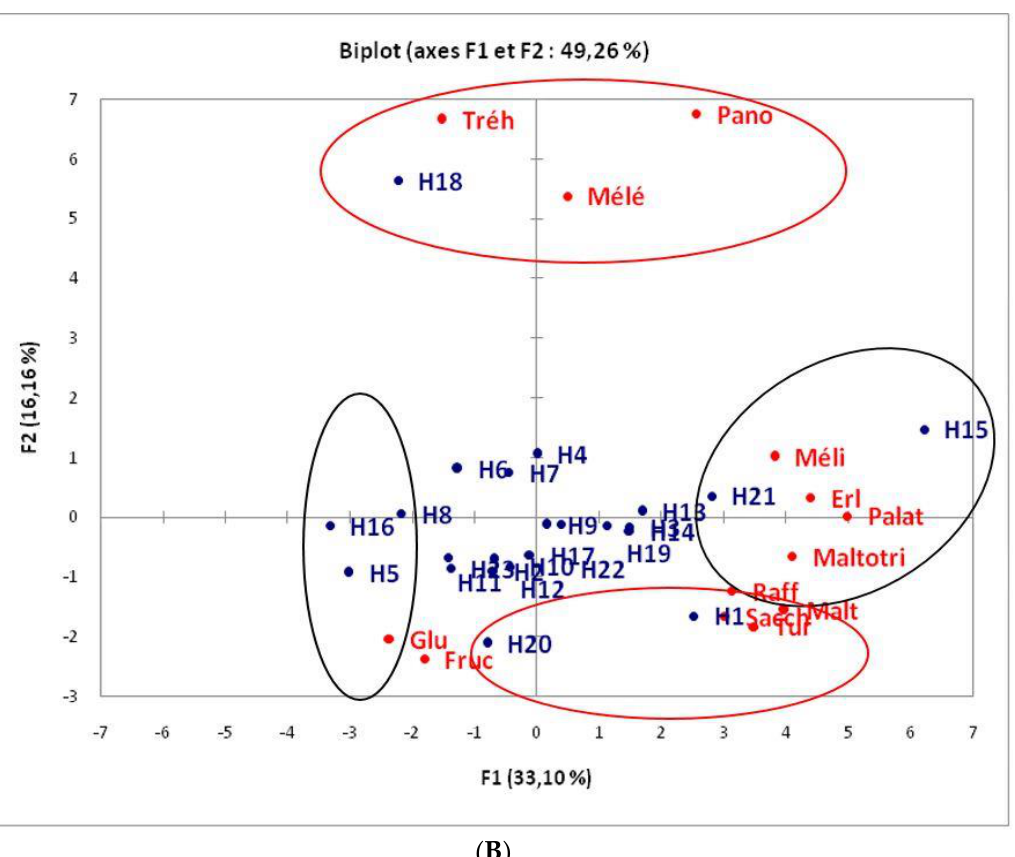
Figure 1. Principal component analysis (PCA) of honey:( A ) PC1:30.72%, PC2:26.08.07%; and ( B ) PC1:33.10%, PC2:16.16%. Relationship between honey physicochemical and sugar profile (score and loading biplot). Aw: water activity, TPC: total phenolic compounds, color, pH, HMF: hydroxy me- thyl furfural, TSS: total soluble solids, MOI: moisture, LA: lactonic acidity, FA: free acidity, CON: